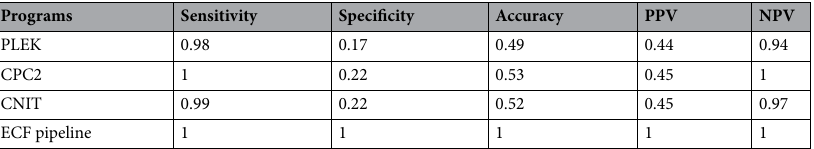
Table 3. Performance of lncRNA identification tools and ECF pipeline on selected Androctonus crassicauda dataset. Sensitivity, specificity and accuracy were calculated using the formulae mentioned in methods and listed in this table.